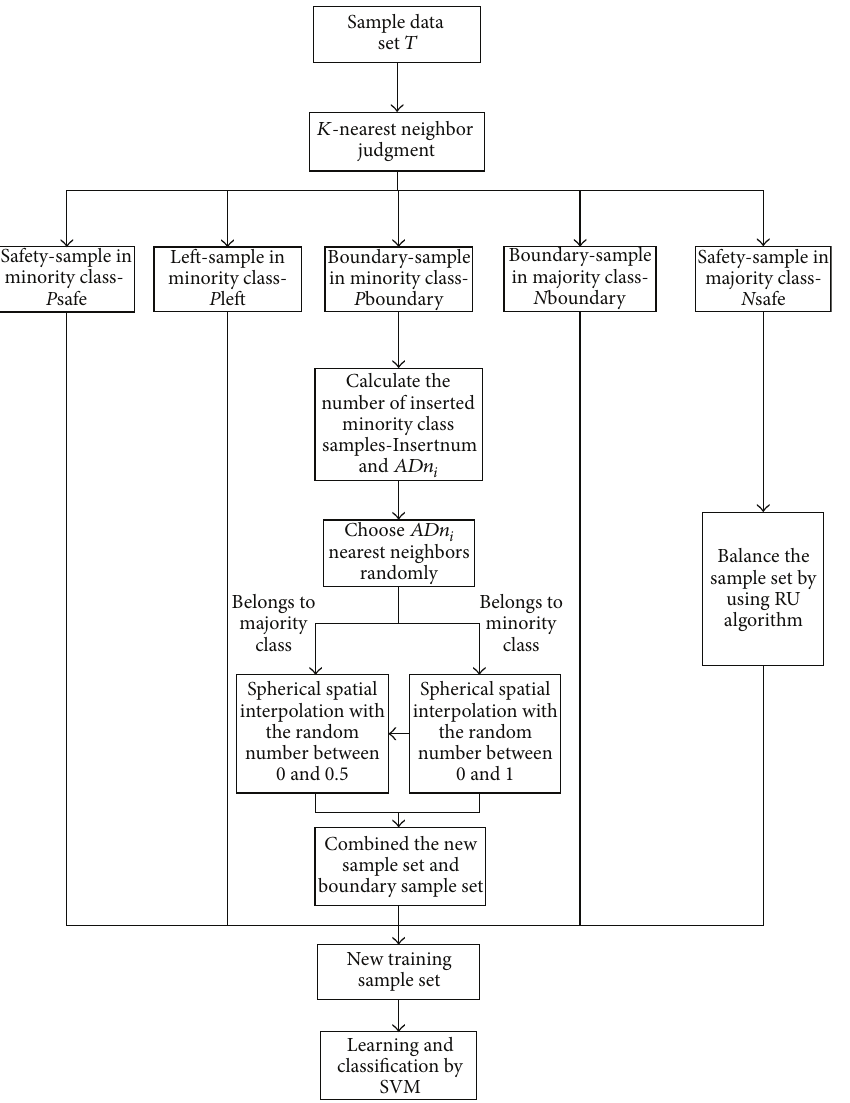
Figure 3: Flow chart of RU-AIBSMOTE algorithm.